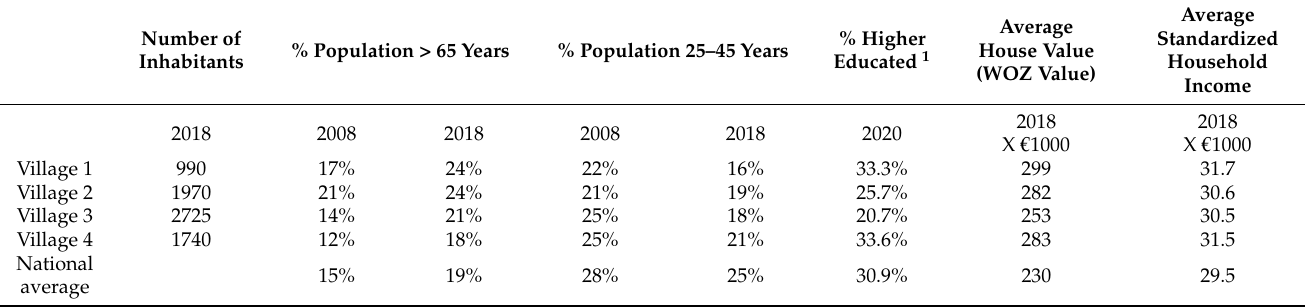
Table 1. Demographic and economic characteristics of the four Dutch KRAKE